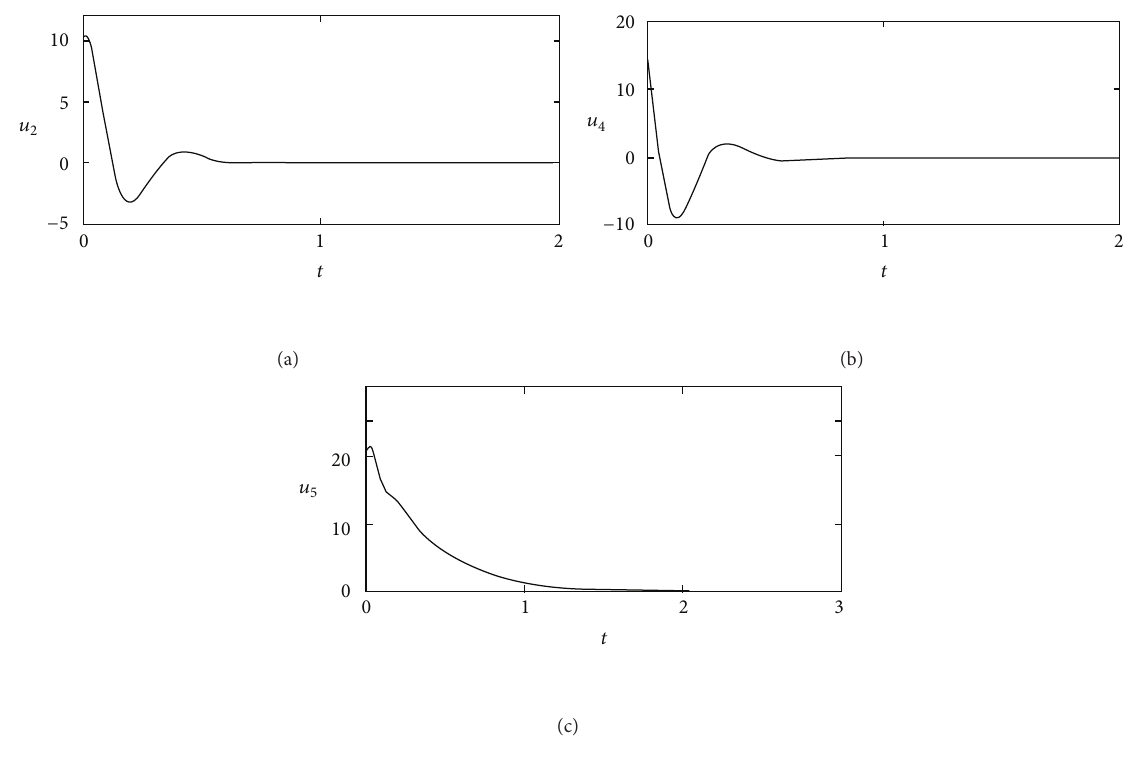
Figure 3: Time evolution for ( 𝑢 2 , 𝑢 4 , and 𝑢 5 ) at 𝑝 0